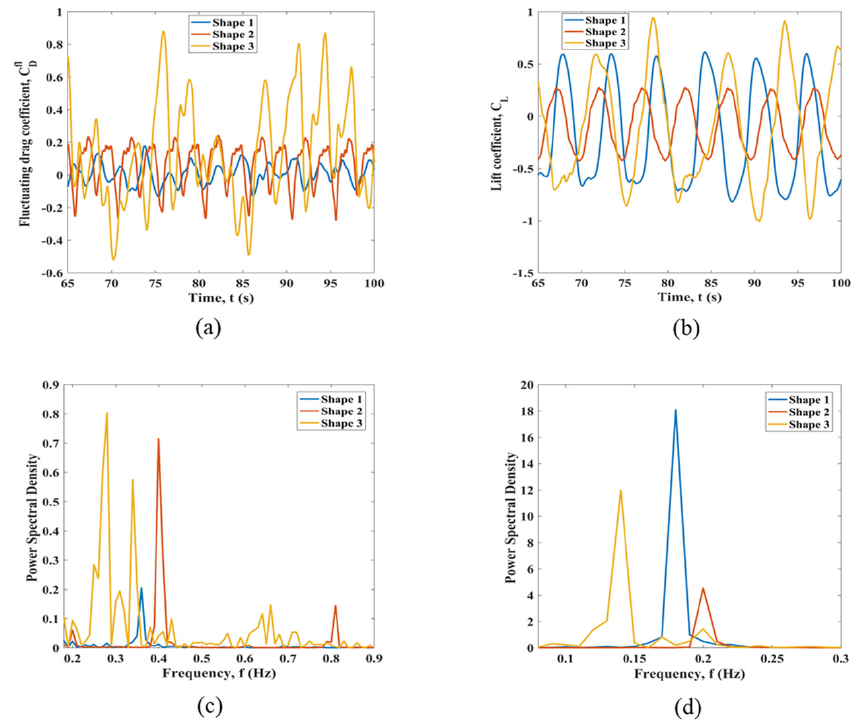
Figure A18. Fluid force coefficients for cylinder 4 immersed in planar sheared flow: ( a ) time history of the fluctuating drag coefficient; ( b ) time history of the lift coefficient; ( c ) the fluctuating drag co–efficient FFT; ( d ) the lift coefficient FFT.